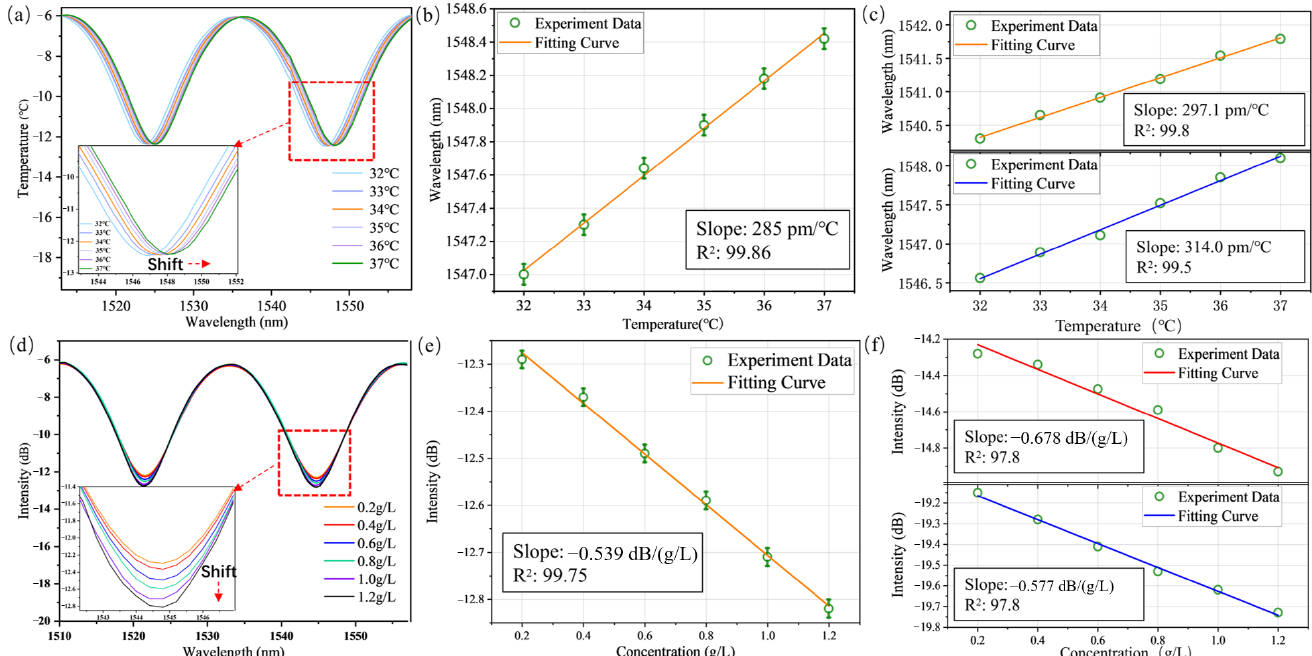
Figure 4. ( a ) Dips of FP interference reflection spectrum shifting with the temperature change. ( b ) The relationship between the dips shifts and the temperature variation in HCSP-1. ( c ) The temperature response of HCSP-2 and HCSP-3. ( d ) Dips of FP interference reflection spectrum shifting with the concentration of glucose solutions change. ( e ) The relationship between the intensity change in the interference dip and the concentration variation in HCSP-1. ( f ) The concentration response of HCSP-2 and HCSP-3.